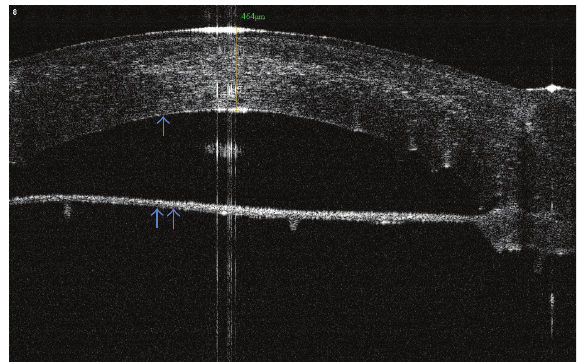
Figure 3: A case of DALK presenting persistent Descemet’s mem- brane detachment (double arrow). The surgeon noted extended detachment during the Big-Bubble procedure, which was not resolved after air injection into anterior chamber. Note the remark- able pachymetry of the donor graft. The Descemet’s membrane anCCd endothelium of the donor were not stripped (single arrow). Three-month followup with RTVue